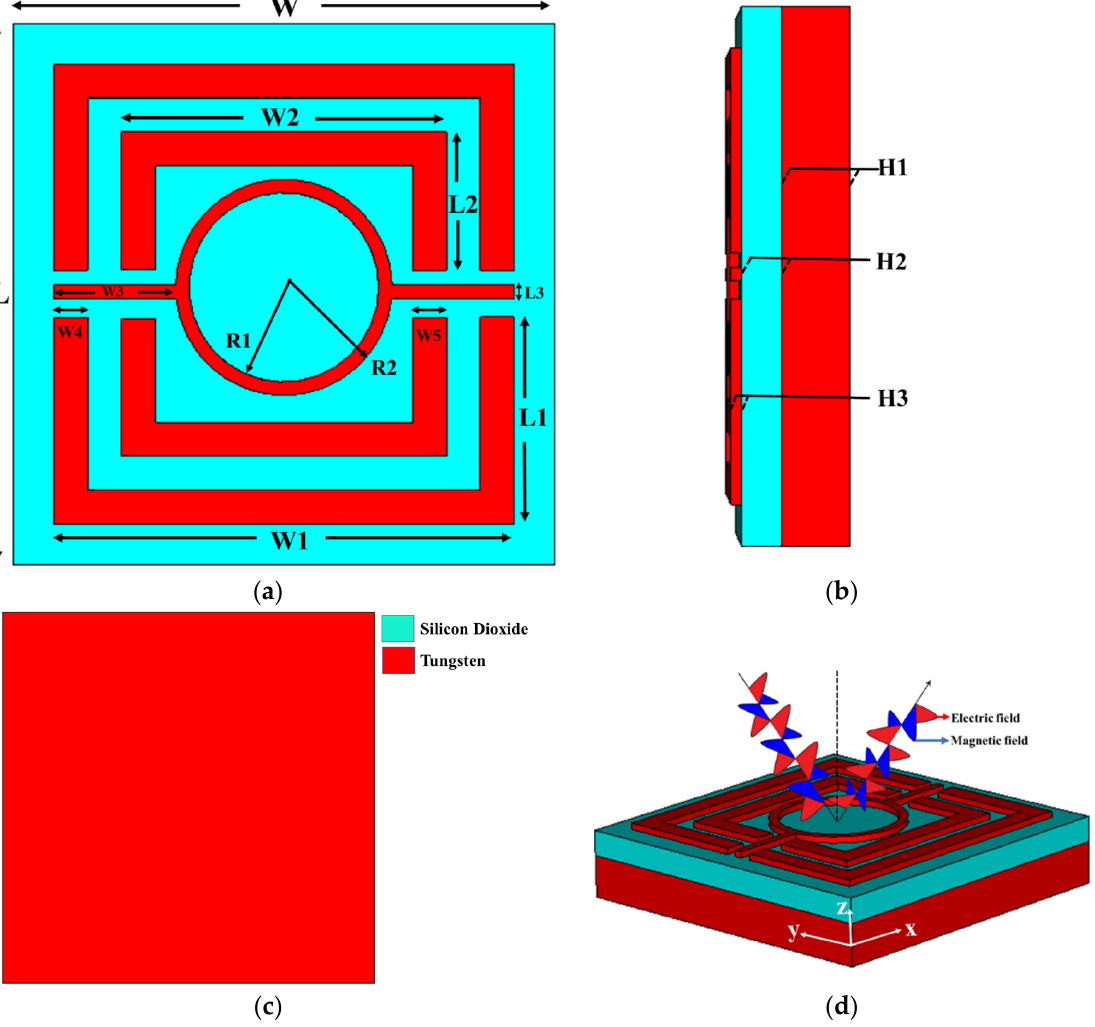
Figure 1. The design of the unit cell for visible optical wavelength applications ( a ) front view ( b ) side view ( c ) back view ( d ) perspective view.